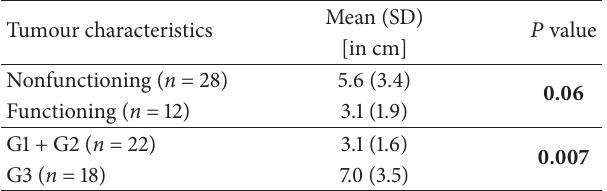
Table 3: Comparison of tumour sizes with respect to functionality and grade.